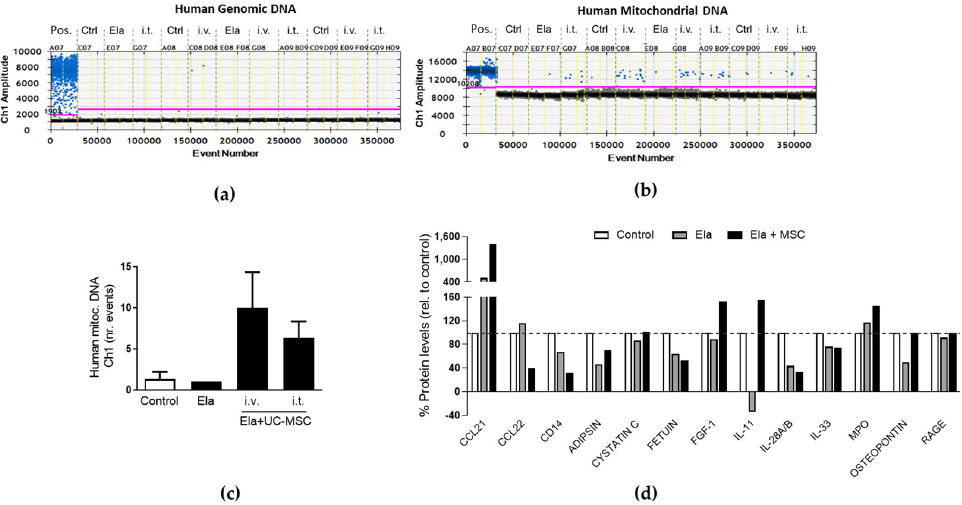
Figure 4. Human mitochondria presence and proteomic cytokine and chemokine profile upon UC-MSC treatment in the elastase model. Analysis of mitochondrial ( a ) and genomic ( b ) human DNA by droplet digital PCR in lungs from control (Ctrl) and elastase-treated (Ela) mice treated with human UC-MSC applied intravenously (i.v.) or intratracheally (i.t.), and ( c ) quantification of the mitochondrial human DNA. ( d ) Protein array of lung homogenates from mice subjected to the same treatments. Pool of at least 3 mice per condition. Abbreviations: UC-MSC (umbilical cord MSC), Ela (elastase), Pos. (positive control), Ctrl (control), i.t. (intratracheally), i.v. (intravenously).